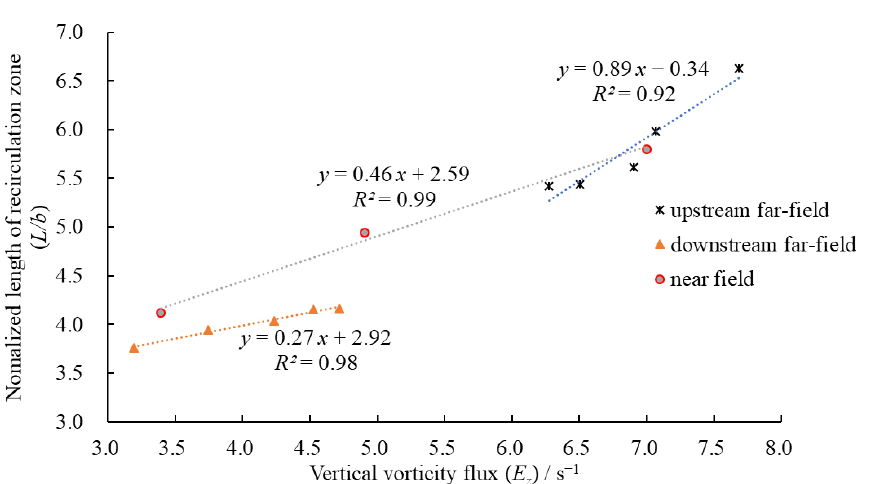
Figure 16. The relationship between vertical vorticity flux and recirculation zone length of Groin A when Groin B is upstream far-field (black * ), downstream far-field (orange triangle) and near field (red circle) from Groin A.